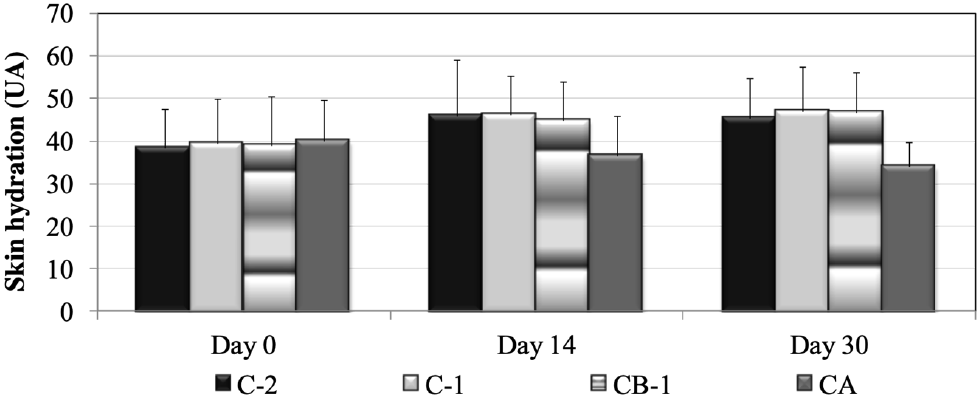
Figure 2. Skin surface hydration over 30 days of treatment with di ff erent cream formulations: cream with concentrated thermal water 2:1 (C-2), cream with thermal water (C-1), cream with laboratory water (CB-1), and evaluation of skin without cream (control area or CA). (mean ± SD, n = 12). Concerning TEWL, no significant differences were found among the creams and between these of a non-occlusive emollient (4.5% of decyl oleate) and the water is its largest constituent. Water is